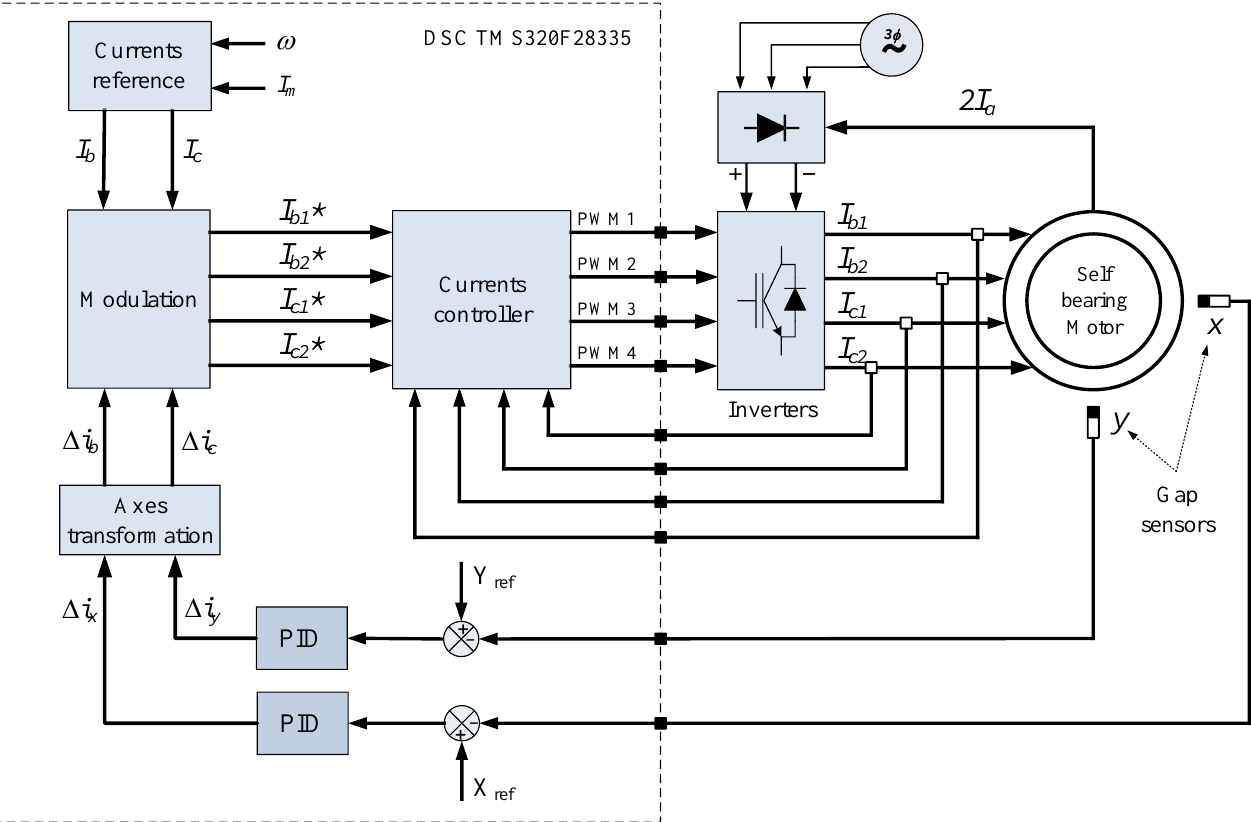
Figure 6. Control